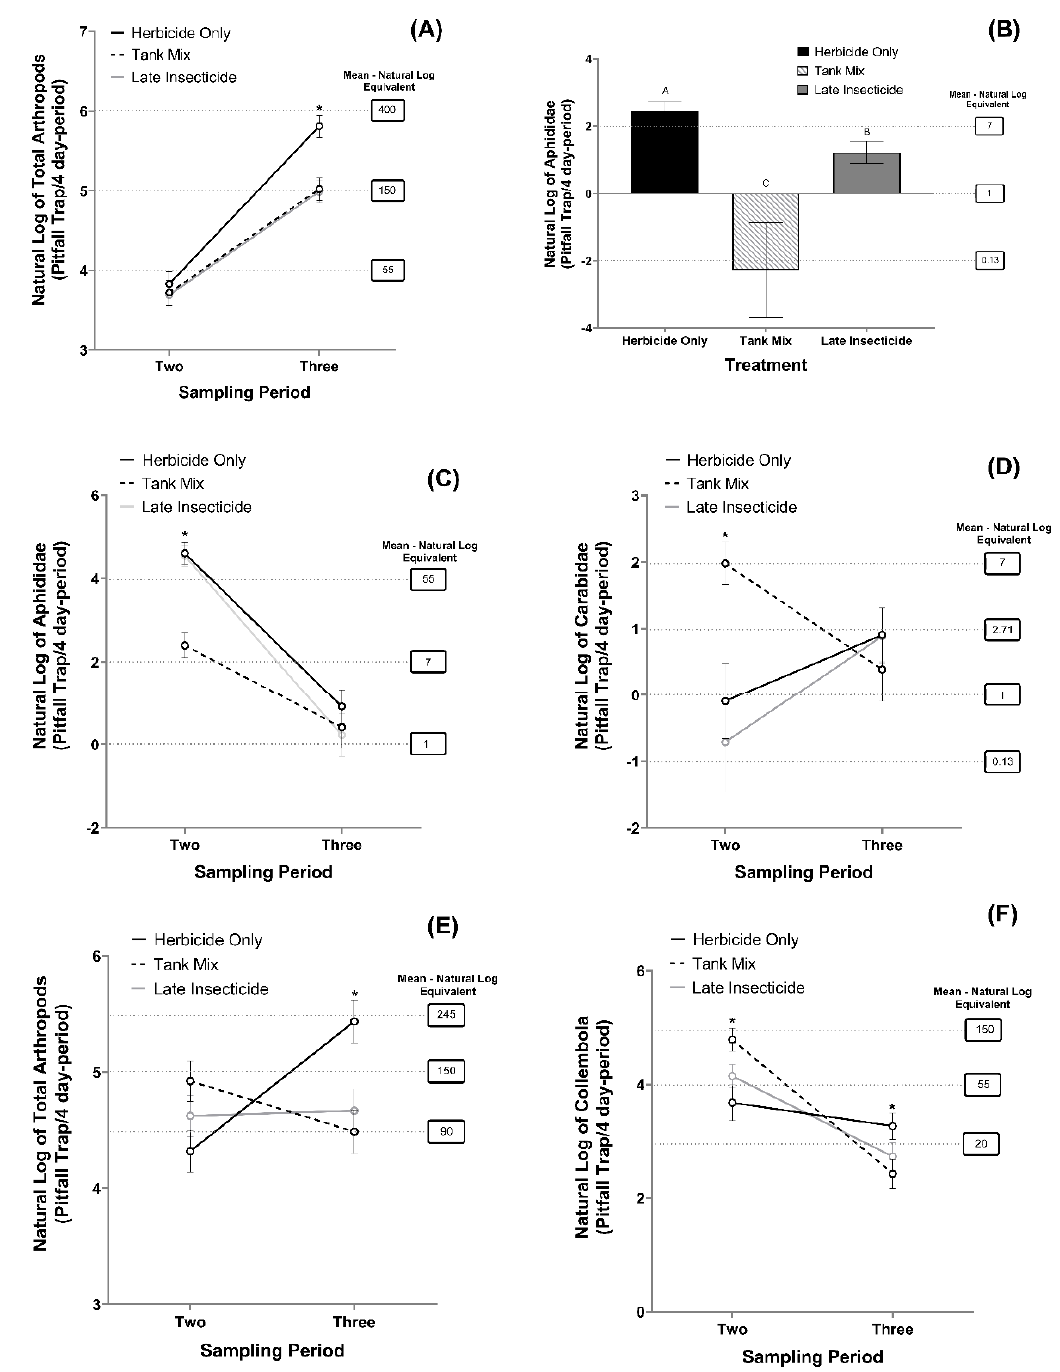
Figure 1. Natural log of total arthropod activity per sampling period and treatment from site 3 ( A ), Aphididae activity per treatment from site 3 ( B ), Aphididae activity per sampling period and treatment from site 5 ( C ), Carabidae activity per sampling period and treatment from site 5 ( D ), of total arthropod activity per sampling period and treatment from site 8 ( E ), and of Collembola activity in log per sampling period and treatment from site 8. Sampling period two was performed at the tank-mix application and three at the late insecticide application time ( F ). Error bars indicate the standard error of the natural log of the means. * Represents statistical difference at p < 0.05 between treatments at a given sampling period. Same letters represent no statistically significant difference at p < 0.05. Grey dash lines indicate the natural log–mean